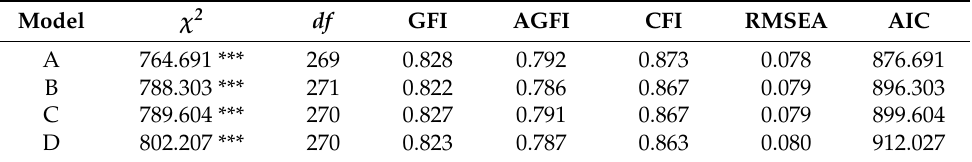
Table 4. The model fitness index of the MSCF for the underlying model A and alternative models B, C, and D (N = 306).